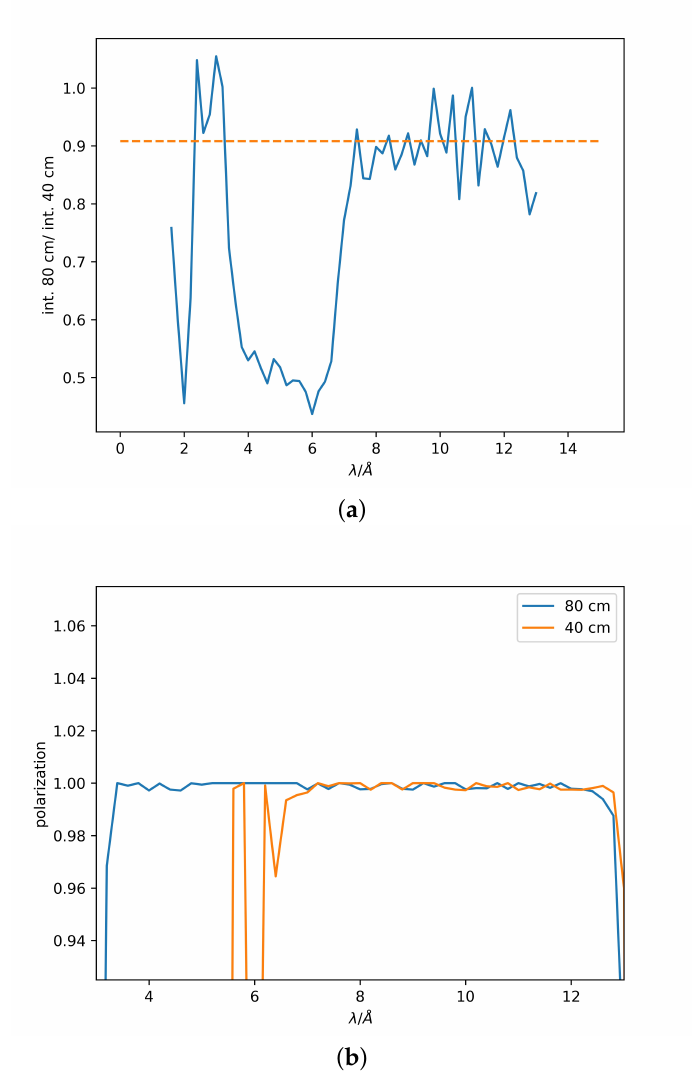
Figure 7. ( a ) Relative transmission of the two polarizer cavities, ( b ) polarization at sample position for the respective polarizer cavities. Simulation was conducted for a 20 m collimation with 1 cm × 1 cm beam size and in pulse skipping mode (i.e., 3–13 Åwavelength band). In order to optimize both, transmission and polarization, the longer cavity is used for the short wavelength band, while the short cavity is used for the long wavelength band. Thus, the poor polarization at low wavelength is avoided for the shorter cavity, and still the higher transmission in the high wavelength band can be used. The vertical line is a fit of the relative intensity between the two cavities for the wavelength between 8 and 13 Å and it indicates a transmission of 90.8% for the 80 cm cavity when compared to the 40 cm cavity. The decreasing polarization at the boundaries of the used wavelength band are binning effects due to zero intensity outside the shown wavelength